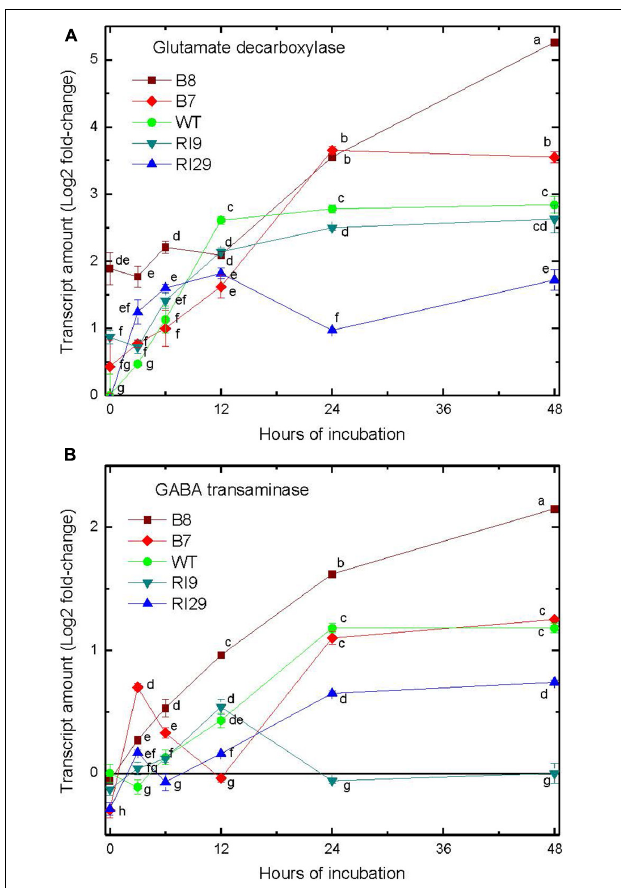
FIGURE 4 | Leaf transcript amount for enzymes of the γ -aminobutyric acid shunt, including glutamate decarboxylase (A) and γ -aminobutyrate transaminase (B) in tobacco plants with differing amounts of alternative oxidase, and exposed to hypoxia at time 0. Vertical bars indicate SD from three independent experiments ( n = 3); different letters indicate significant differences between five tobacco lines and the time